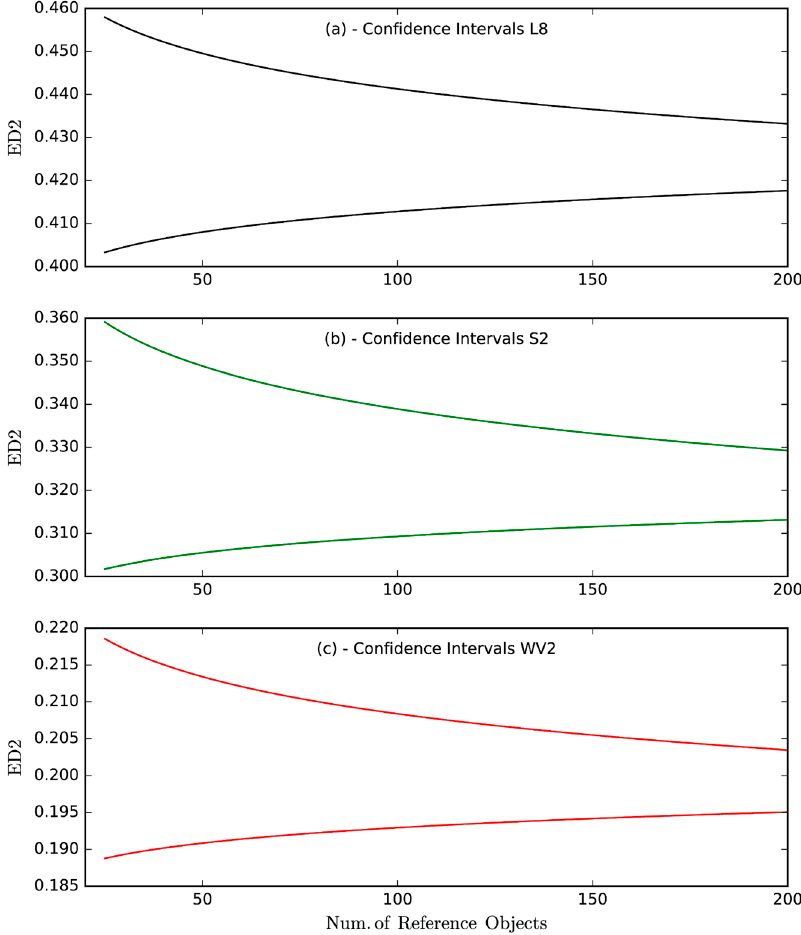
Figure 5. 95% confidence intervals computed from the scatterplots depicted in Figure 4: ( a ) Landsat 8; ( b ) Sentinel-2; ( c ) WorldView-2.